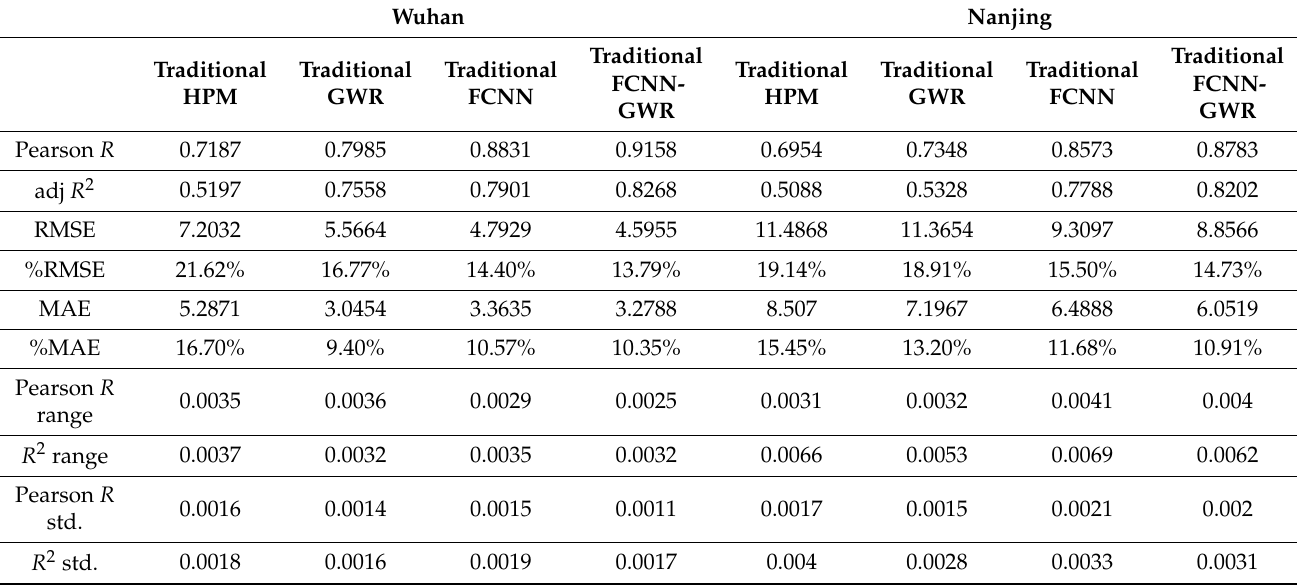
Table A2. Accuracy assessment results of each